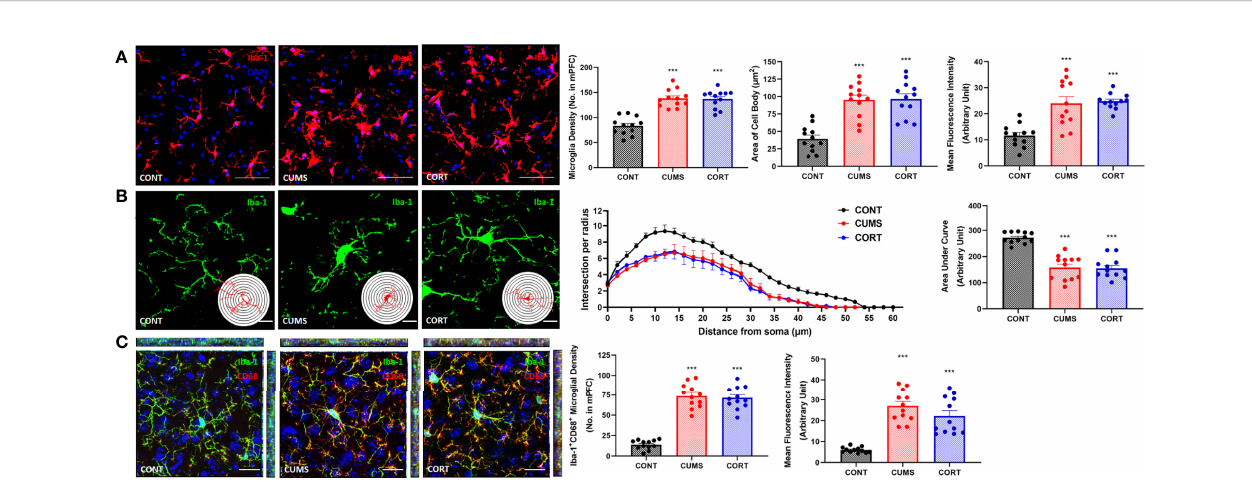
FIGURE 4 | Mice with chronic stress were accompanied with microglial activation in mPFC. (A) Representative immuno fl uorescence images showing the Iba-1 + microglia in CONT, CUMS, and CORT groups were presented, and the microglial density, area of cell body, and the MFI of Iba-1 were analyzed (two-way ANOVA with Tukey ’ s post hoc test post hoc , *** P < 0.001, compared with CONT. Two replica for n = 6). Scale bar: 40×. (B) Representative immuno fl uorescence images showing the 3D reconstruction of Iba-1 + microglia in CONT, CUMS, and CORT groups were presented, and Sholl analysis and their AUCs were analyzed (two-way ANOVA with Tukey ’ s post hoc test post hoc , *** P < 0.001, compared with CONT. Two replica for n = 6). Scale bar: 126×. (C) Representative immuno fl uorescence images showing the co-localization of CD68 + and Iba-1 + microglia in CONT, CUMS, and CORT group were presented, and the Iba-1 + CD68 + microglial density and also the MFI of CD68 were analyzed (two-way ANOVA with Tukey ’ s post hoc test post hoc , *** P < 0.001, compared with CONT. Two replica for n = 6). Scale bar: